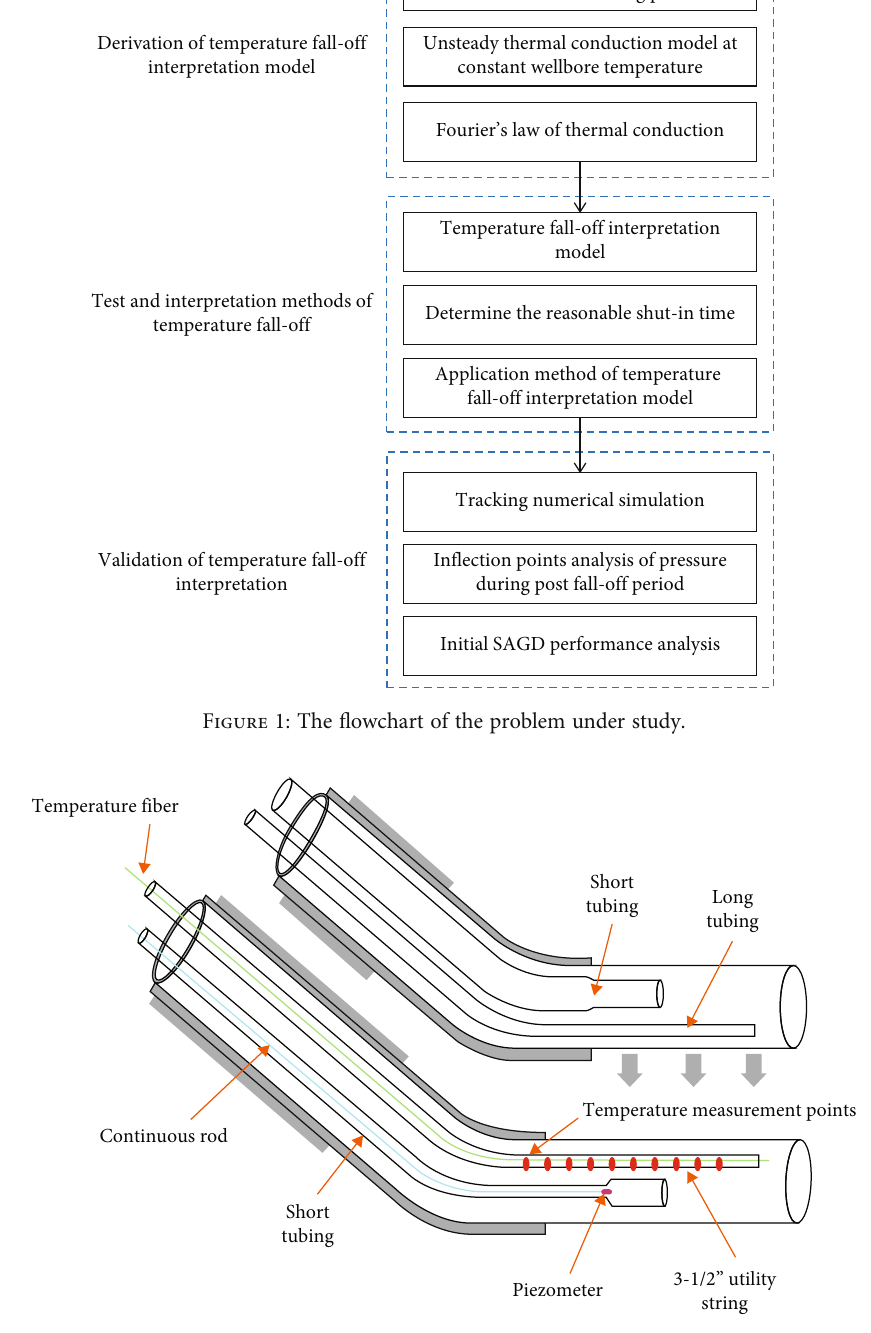
Figure 2: Completion and temperature and pressure monitoring process of dual horizontal